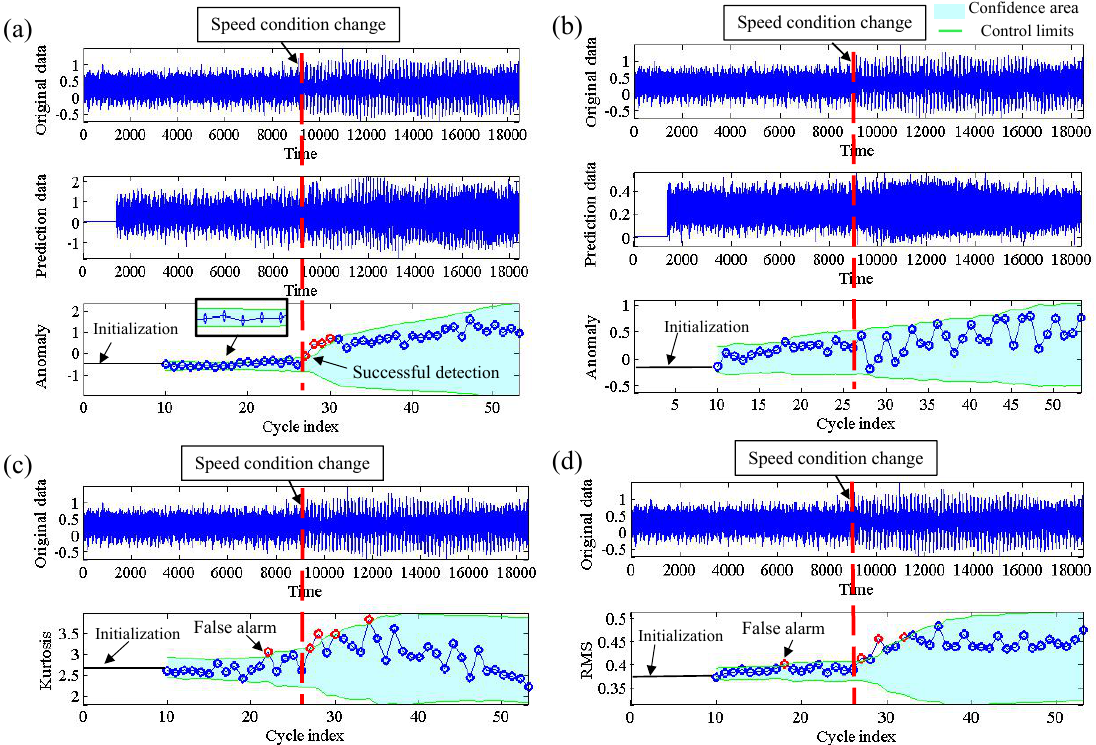
Figure 6. An example of change detection of speed condition change from 350 rpm to 400 rpm. ( a ) DE model; ( b ) ARIMA model; ( c ) Kurtosis; ( d )